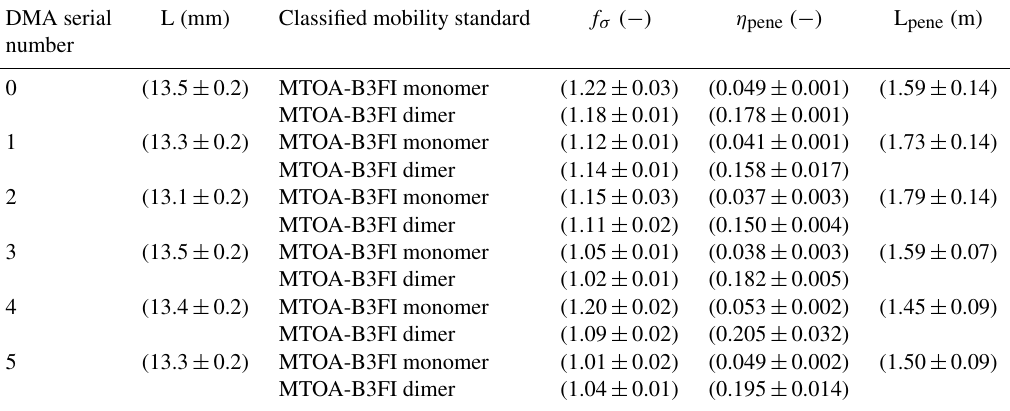
Table 1. Voltage–mobility calibration and transfer function characteristics of all Grimm S-DMAs used. L is the calibrated classification length of the DMA, f σ accounts for additional transfer function broadening and L pene represents an effective diffusional length for inlet and outlet losses of the DMA.